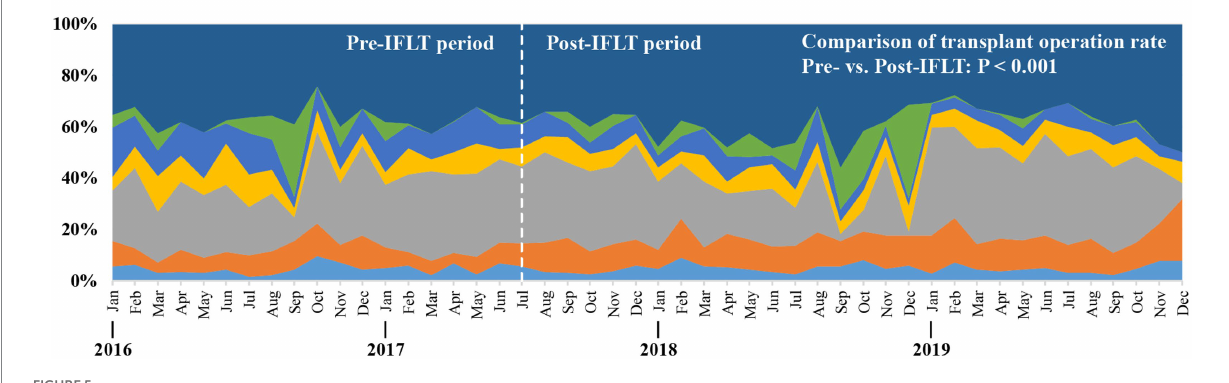
FIGURE 5 The ratio of major DRGs varies monthly from 2016 to 2019. DRGs, Diagnosis-related groups. Definition of main DRGs in the organ transplant department: AB19, Liver transplant. AE19. Renal transplant. HZ15, Other liver diseases without comorbidities and concomitant diseases. LZ15, Other urinary system diseases, without comorbidities and concomitant diseases. LJ13, other operations of the urinary system with comorbidities and concomitant diseases. XS23, followed up patients with complications and concomitant diseases.